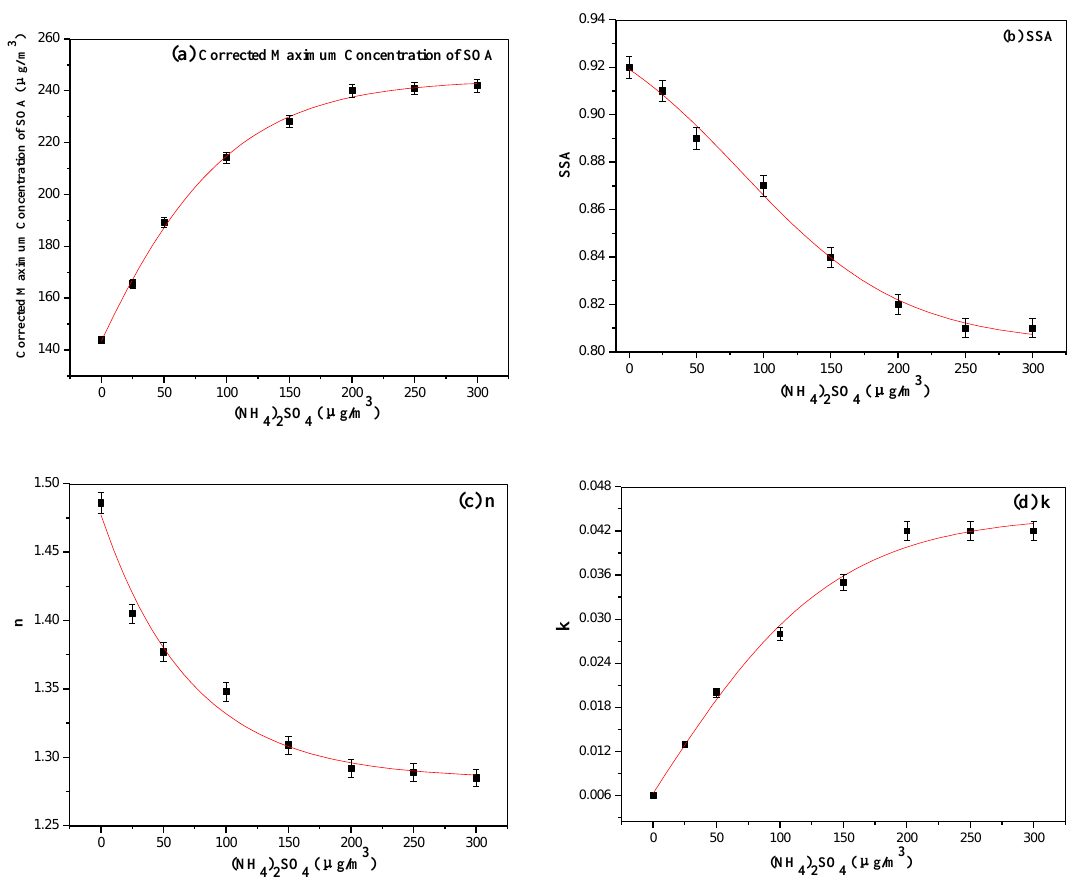
Figure 5. The ( a ) corrected maximum mass concentration ( b ) SSA ( c ) n and ( d ) k of SOA particles measured at different concentrations of (NH 4 ) 2 SO 4 seed.